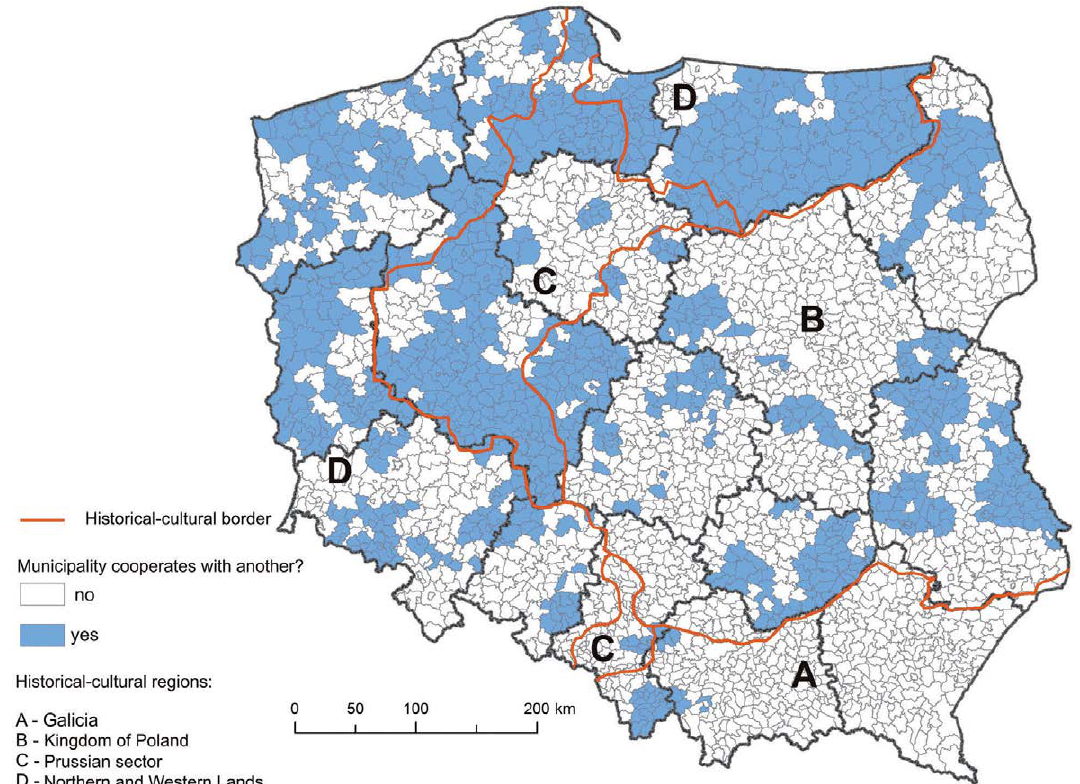
Fig. 2. Municipalities cooperating in waste management, by historical-cultural region. Source: own